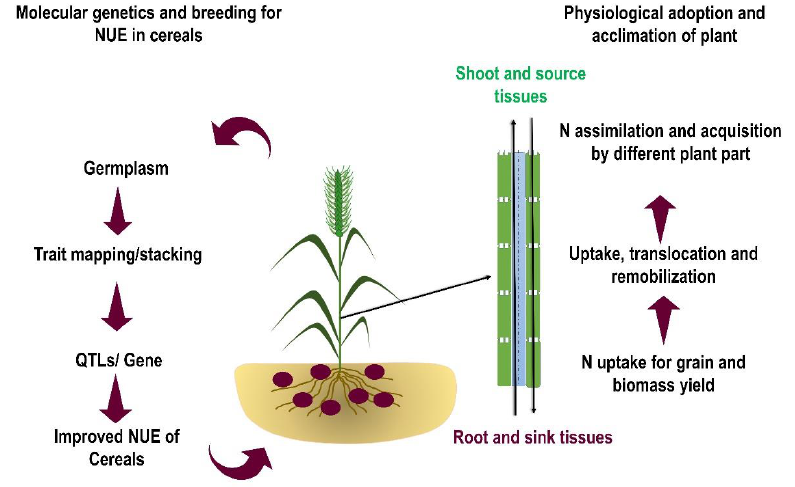
Figure 7. Molecular breeding for enhancing NUE in cereals.